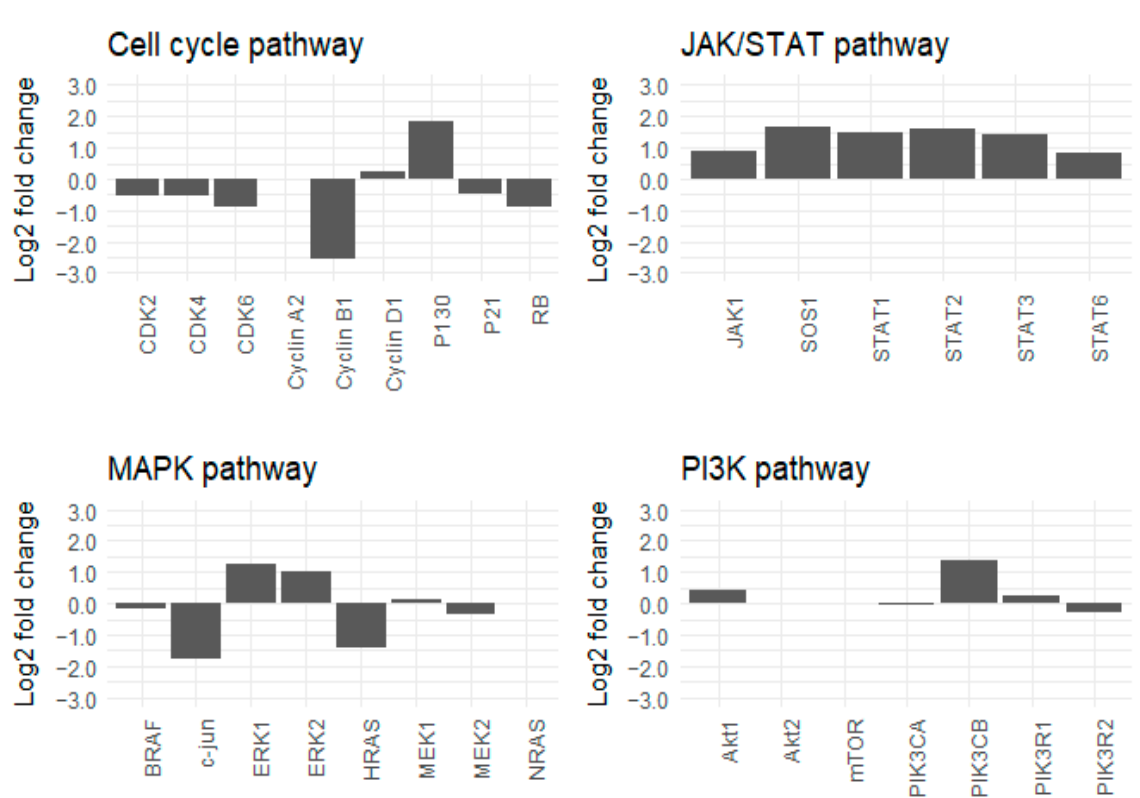
Figure 3. CAL27 cell line: Log2-fold change in values determined by proteomic analyses for proteins identified as im- portant regulators of the cell cycle, JAK/STAT, PI3K/Akt and MAPK pathways.